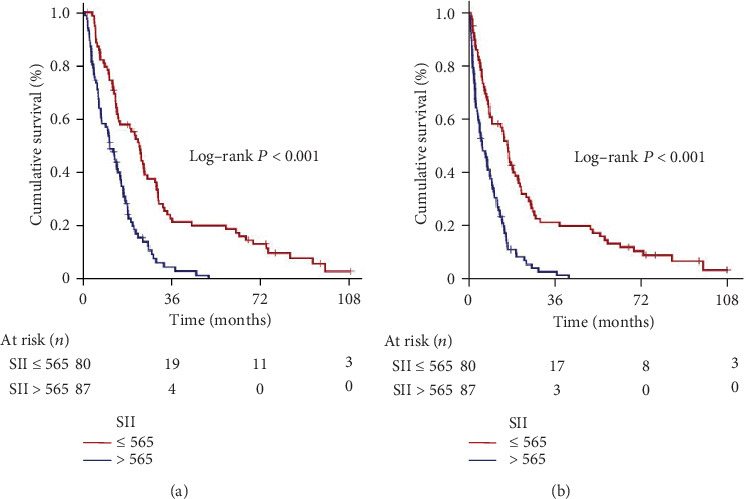
Survival outcomes per conveyance systemic immune-inflammation index groups. (a) Progression-free survival. (b) Overall survival (red: low systemic immune-inflammation index; dark blue: high systemic immune-inflammation index).